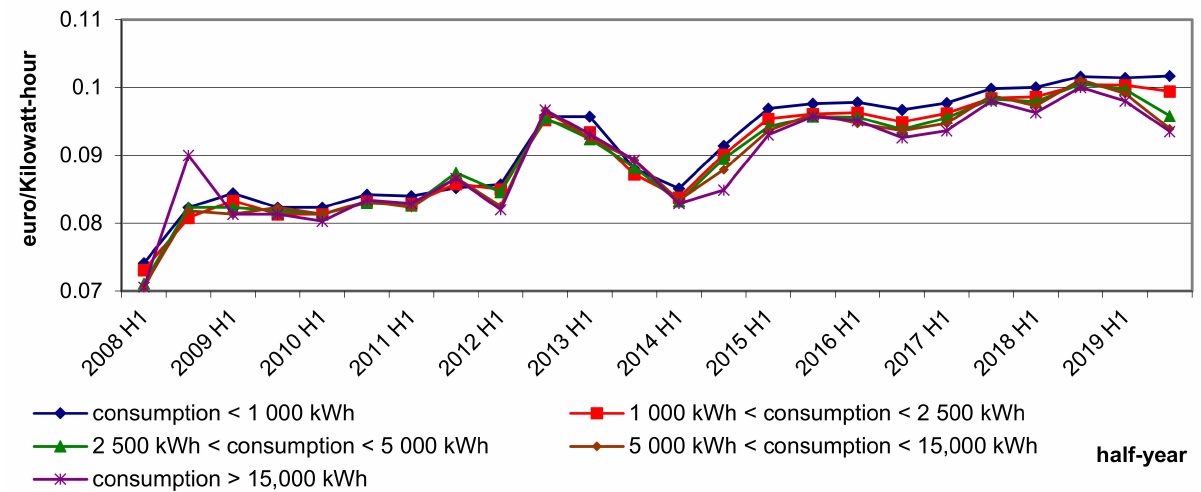
Figure 7. Electricity prices for private customers in Bulgaria in